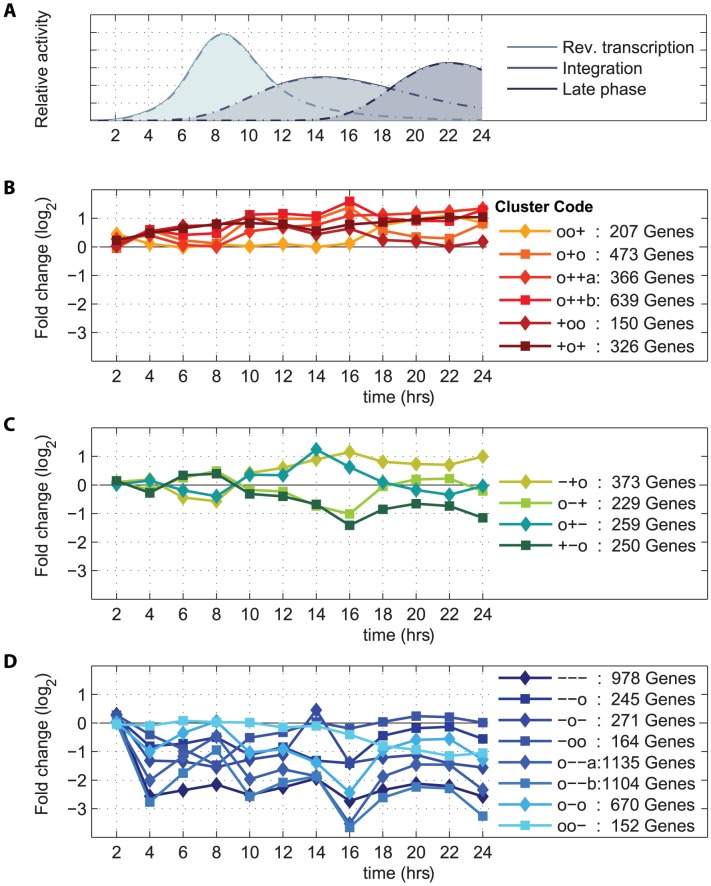
Clusters of host genes correlated with viral progression.Temporal expression patterns of 7,991 genes modulated in concordance with key steps of viral replication (panel A) were grouped into 18 clusters with differential expression profiles at three phases of the viral life cycle, namely reverse transcription, integration, and late phase. The cluster code characters ‘+’ and ‘−’ mark significant (p<10−2) upregulation and downregulation, respectively, while ‘o’ indicates no significant deviation from zero. For example, the cluster ‘−+o’ contains 373 genes downregulated during reverse transcription, upregulated during integration, and unregulated during the late phase. In total, six upregulated clusters (B), four clusters with mixed patterns of regulation (C), and eight downregulated clusters (D) were found. Details of clusters are available at the dedicated web resource [6].